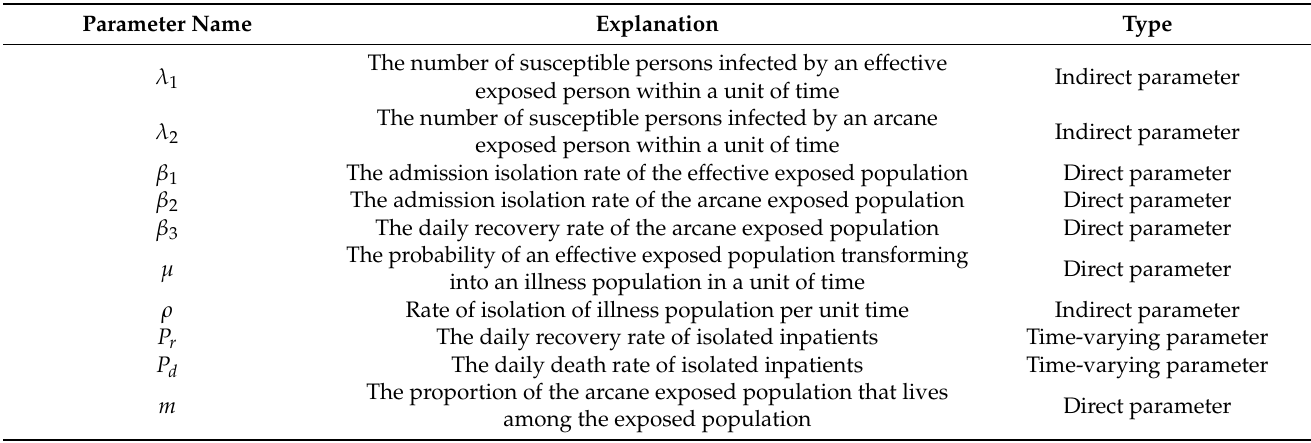
Table 1. Explanation of